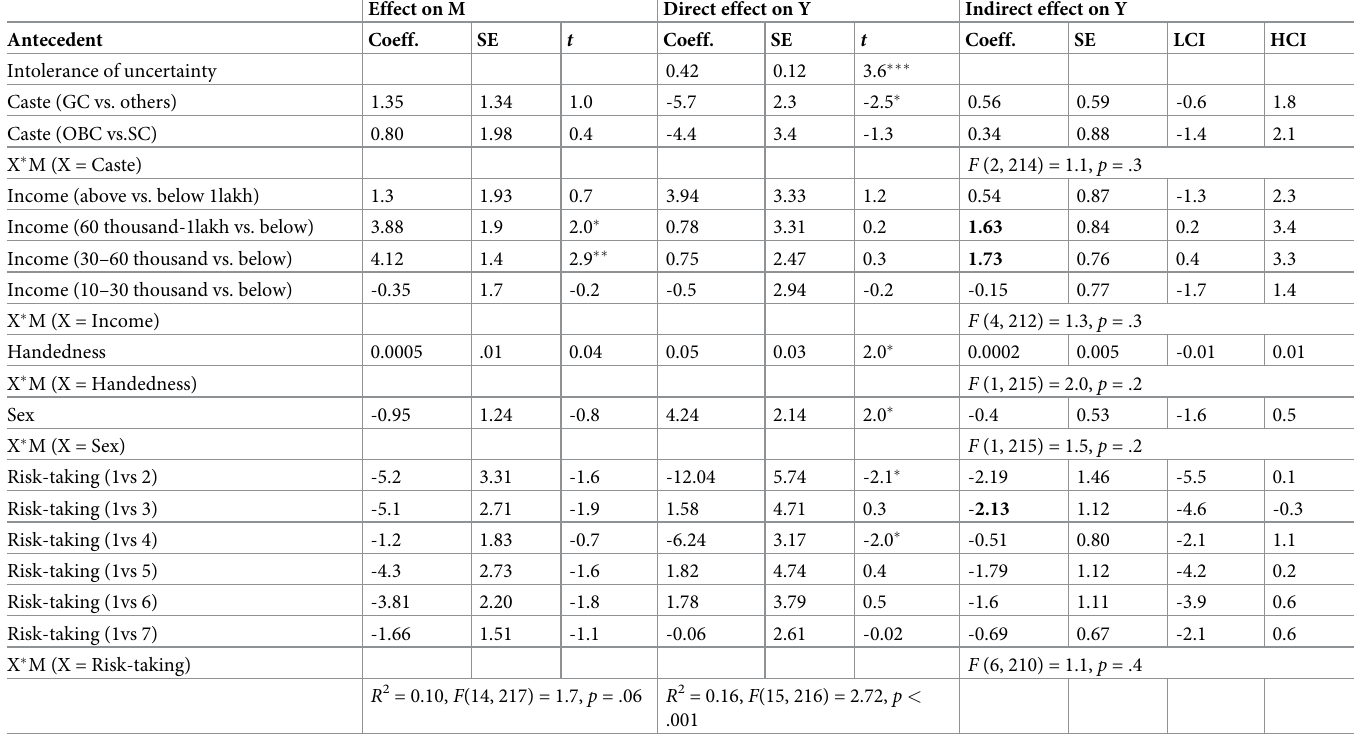
Table 11. The effects (direct and indirect effects) of antecedent variables on the mediation variable (general IU) and the dependent variable (religiousness) in the community sample.